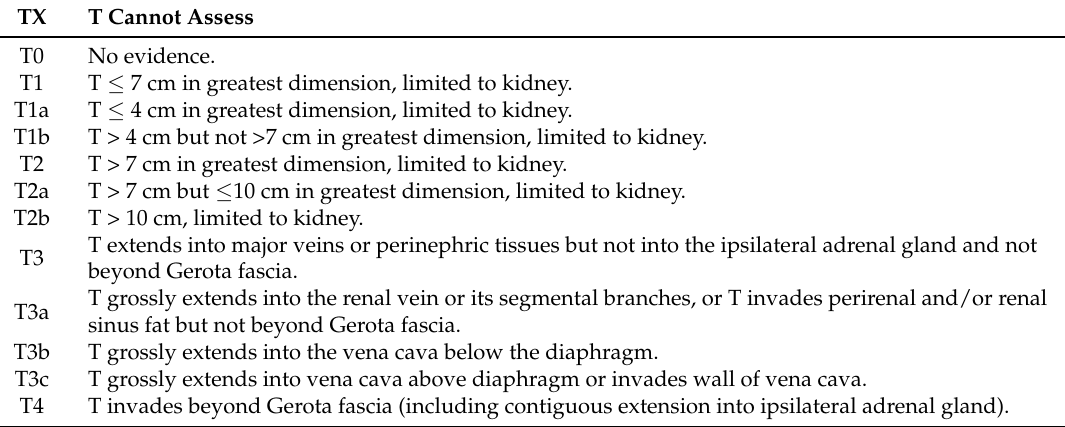
Table 2. Primary Tumor (T) Stages in Renal Cell Carcinoma.